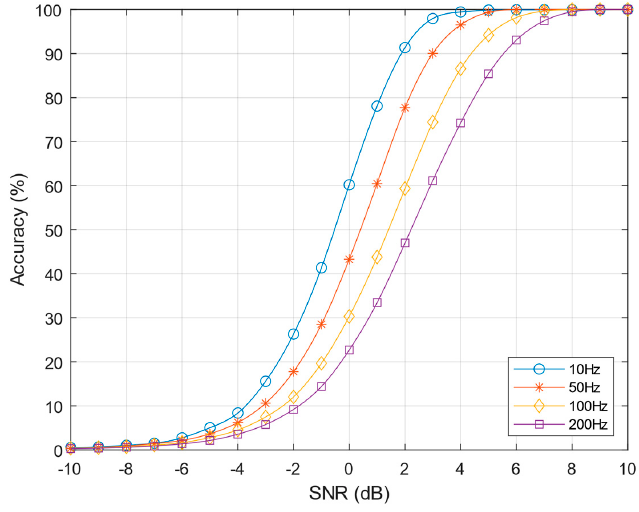
Figure 7. SNEO accuracy at k = 4 varying the action potentials (APs) firing rate from 10–200 Hz, scale factor C = 5.